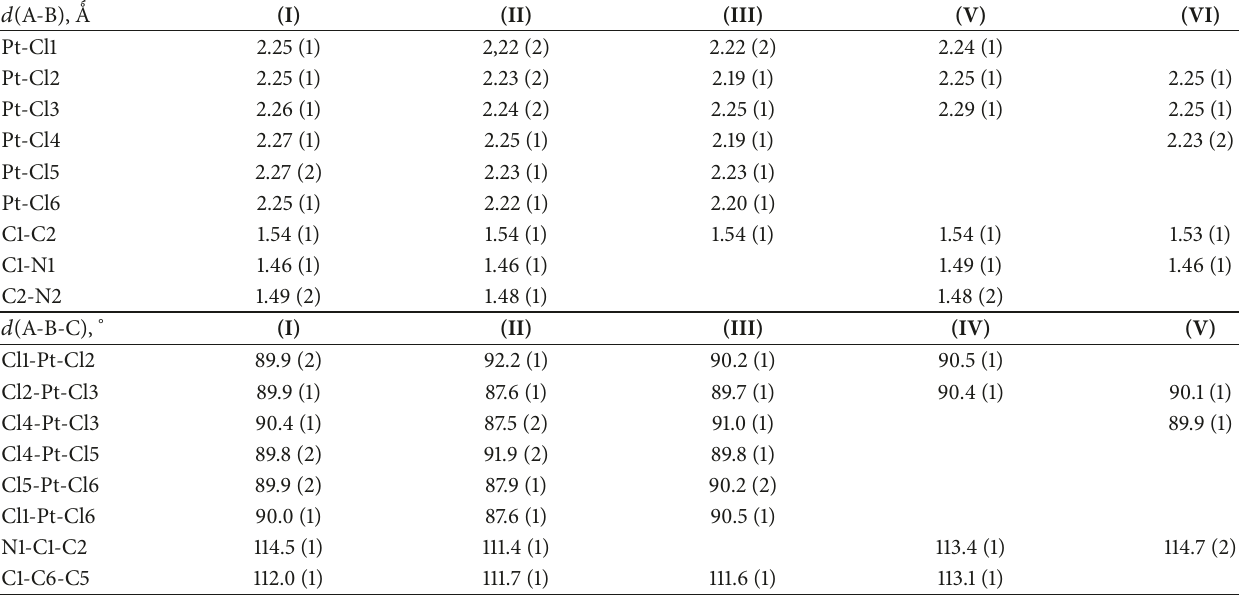
Table 2: Some of the bond lengths and angles in compounds (I) – (III) , (V) , and (VI)